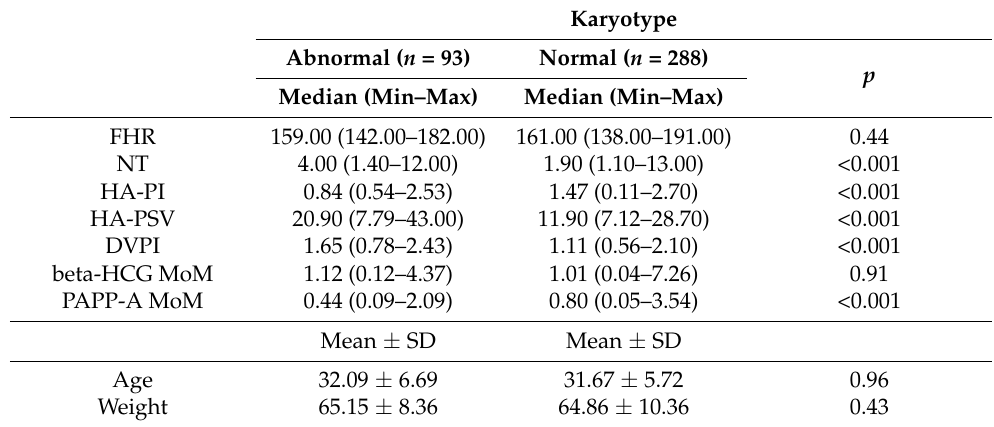
Table 3. Differences between selected first-trimester screening parameters in adverse pregnancy outcome pregnancies depending on the